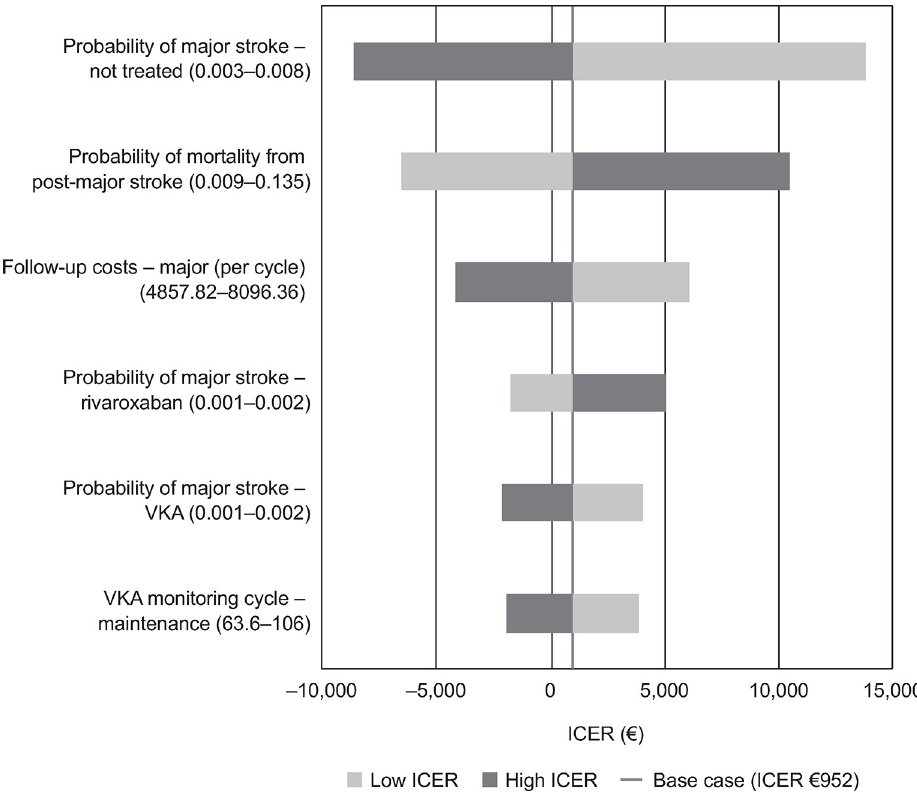
Fig 1. Rivaroxaban tornado diagram. ICER, incremental cost-effectiveness ratio; VKA, vitamin K antagonist.